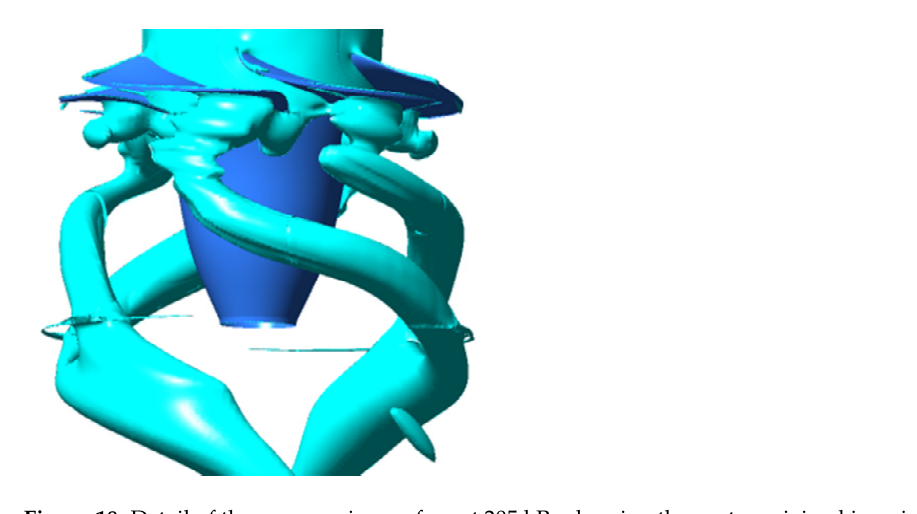
Figure 18. Detail of the pressure iso-surface at 205 kPa showing the vortexes joined in pairs. The axial velocity is positive only on the periphery of the numerical domain (Figure 19). The velocity contour plotted on the mid-section plane shows a large recirculating area in the center of the draft tube. A stagnation area with very low but positive velocity is present in the draft tube diffuser near the outlet of the domain. The backflow regions extend upstream from the runner blades near the hub, but also near the shroud towards the outlet of the guide vane domain.